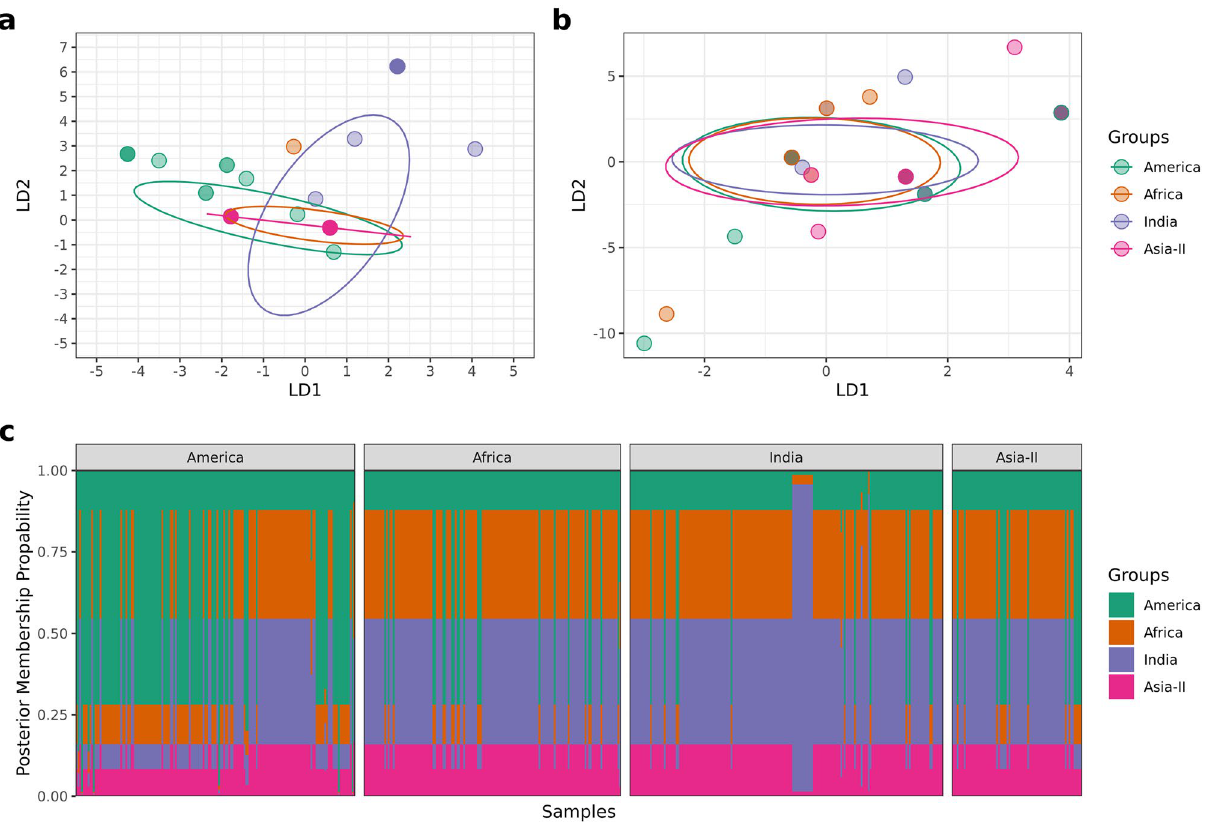
Figure 6. DAPC analysis. ( a ) Clustering of four geographical groups by discriminant analysis of principal components (DAPC) of S. frugiperda samples (n = 572). ( b ) DAPC analysis of S. frugiperda samples (n = 572) after randomly assigning geographical groups to samples showing no discrimination between clusters. ( c ) Posterior membership probability plot shows posterior probability assignment of samples to their respective geographical